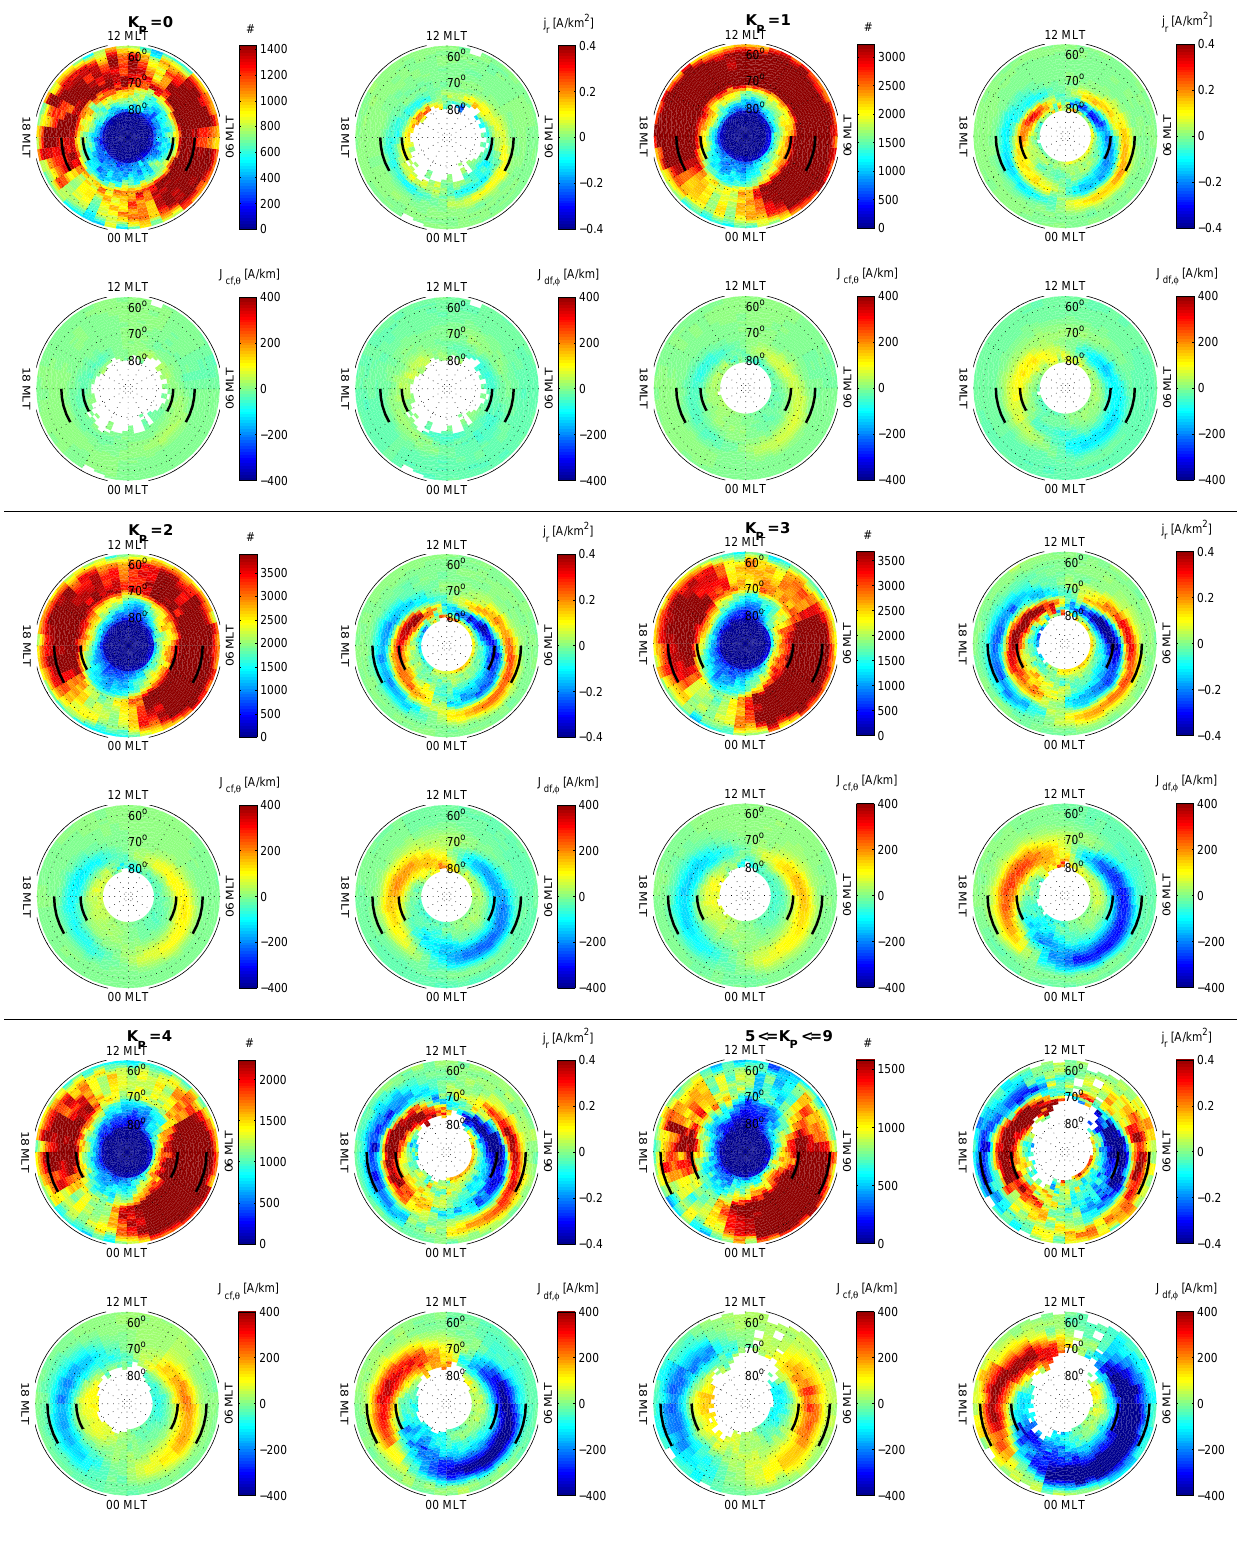
Fig. 6. Ionospheric current density binned with respect to K p